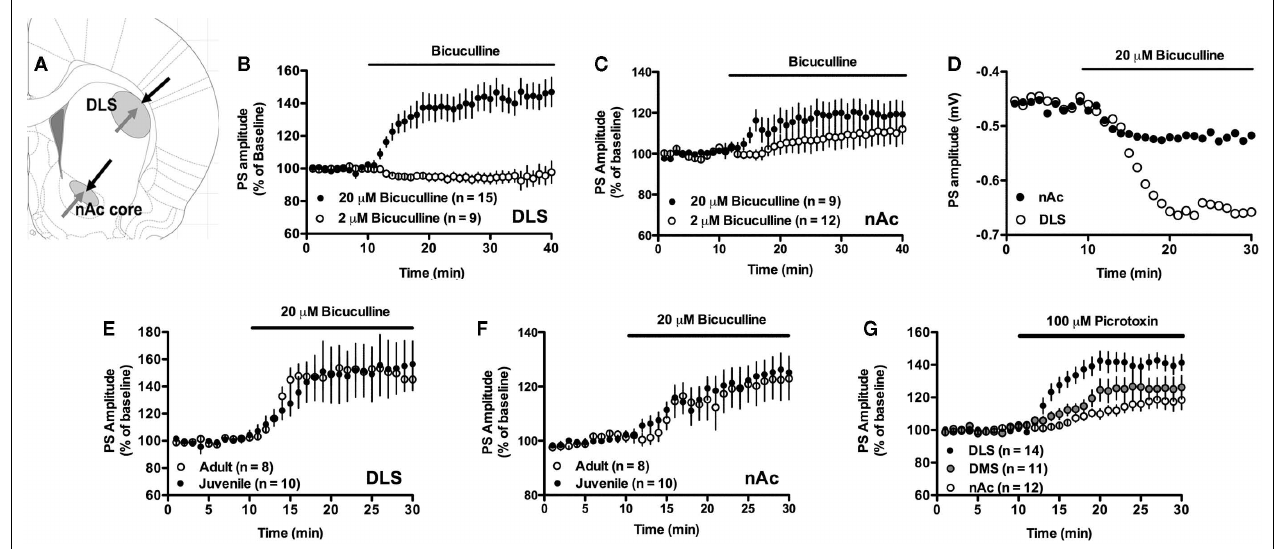
FIGURE 1 | Excitatory input to the striatum is inhibited by GABAergic neurotransmission. (A) Schematic picture showing the location of stimulating electrodes (black) and recording electrodes (gray) in the dorsolateral striatum (DLS) and in the nAc core. (B,C) Treatment with 20 μ M, but not 2 μ M, of the GABA A receptor antagonist bicuculline enhanced PS amplitude in both the DLS and the nAc. (D) Example figure showing absolute